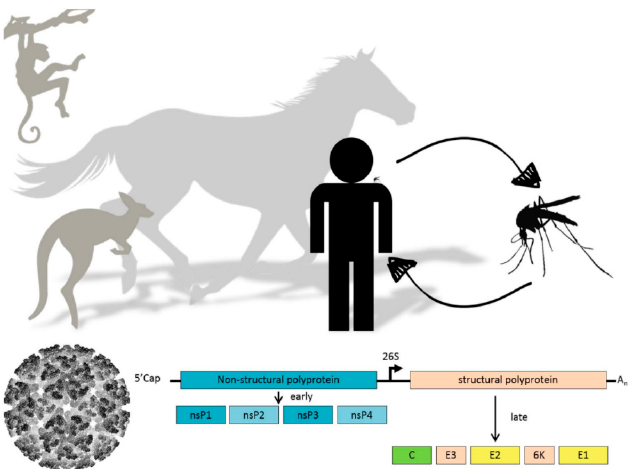
Figure 1. ( Top ) Schematic representation of alphavirus transmission cycle; ( Bottom ) Alphavirus particle and schematic representation of alphavirus genome organization. Translation of the nonstructural polyprotein (blue) can occur immediately from the positive-sense genomic RNA template, whereas the structural polyprotein (yellow) is expressed later in infection from a subgenomic messenger RNA template.